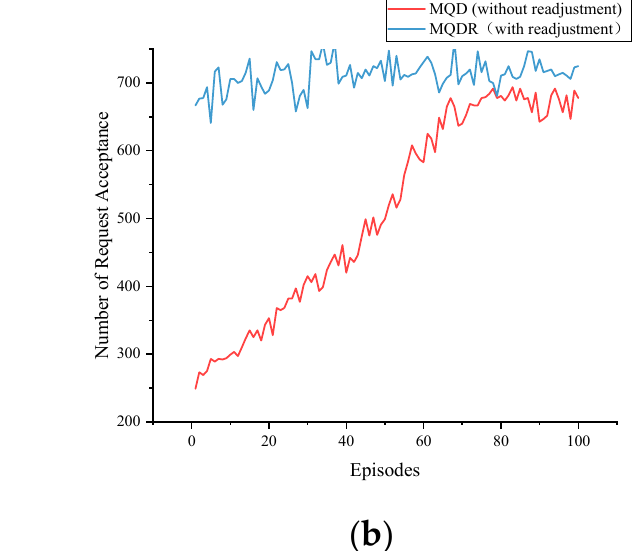
Figure 6. The request acceptance rate of different algorithms.